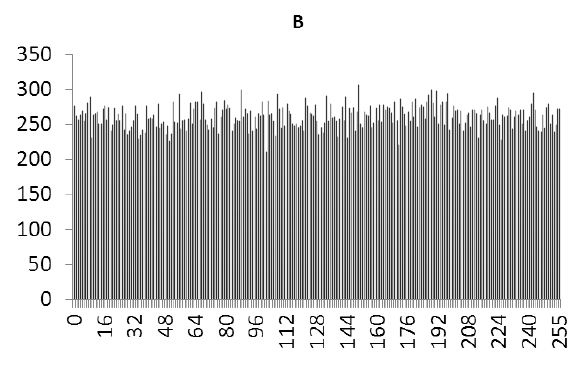
Figure 31. Statistical chart of B value distribution after